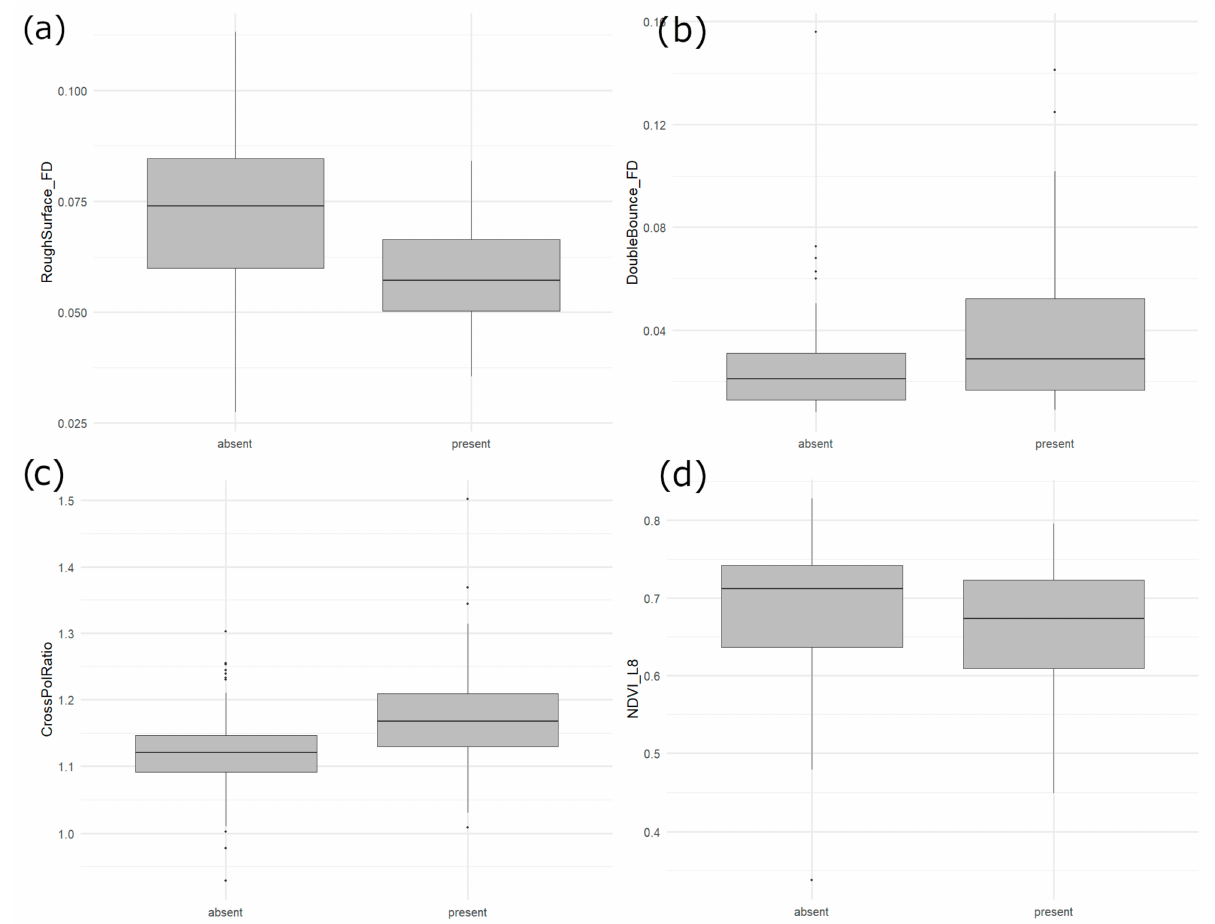
Figure 2. Box plots showing the difference between the EO inputs and YERA site occupancy. Panel ( a ) is the rough surface component of the Freeman-Durden, ( b ) is the double bounce component of the Freeman-Durden, ( c ) is the cross polarization ratio, and ( d ) is